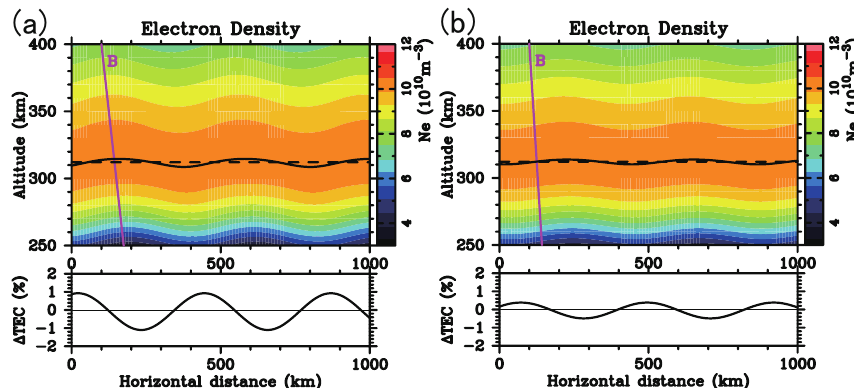
Fig. 6. Same as Fig. 5 but for the plasma density perturbations caused by E × B drift resulting from the oscillating electric field, which is a sinusoidal perturbation with an amplitude of 35ms − 1 , propagating southwestward (225 ◦ from the north). The horizontal wavelength and period are 300km and 40min,